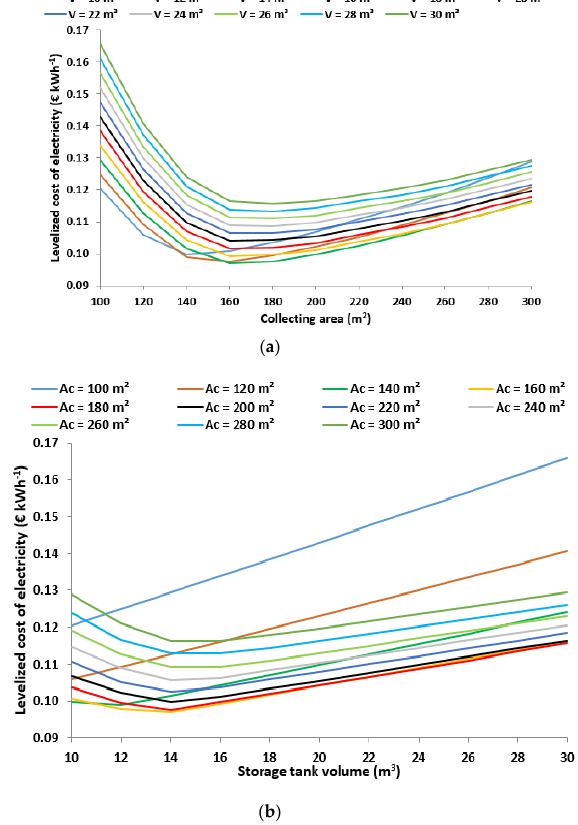
Figure 5. Levelized cost of electricity ( a ) for di ff erent collecting areas with the storage tank volume as the main parameter ( b ) for di ff erent storage tank volumes with the collecting area as the main